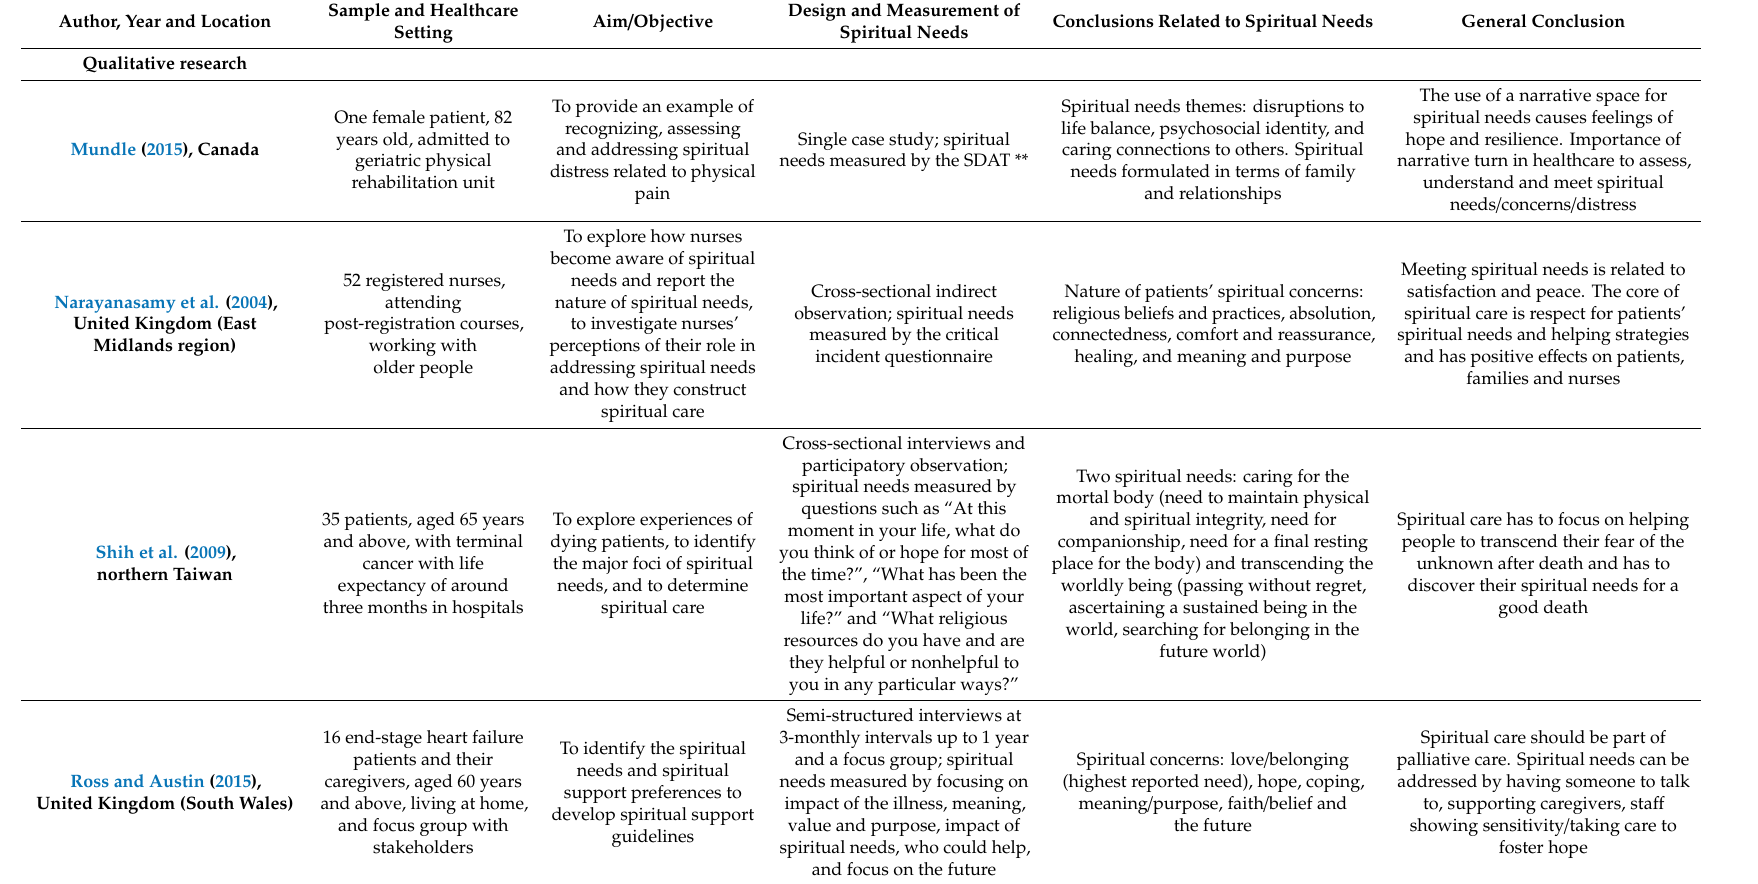
Table 3. Overview of study characteristics of reviewed